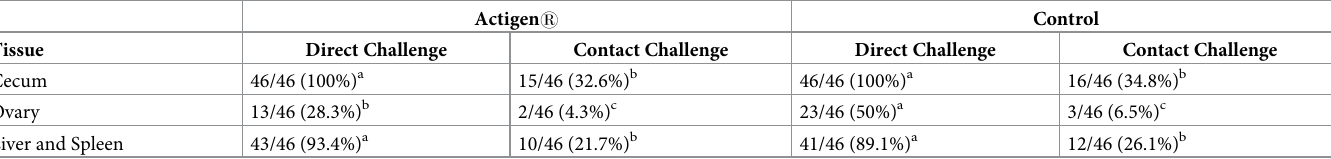
Table 1. Effects of a mannan-rich yeast cell wall dietary supplement on the detected frequency of nalidixic acid resistant Salmonella Enteritidis in the tissue samples from 17-week-old layers 1 week after direct or contact challenge.